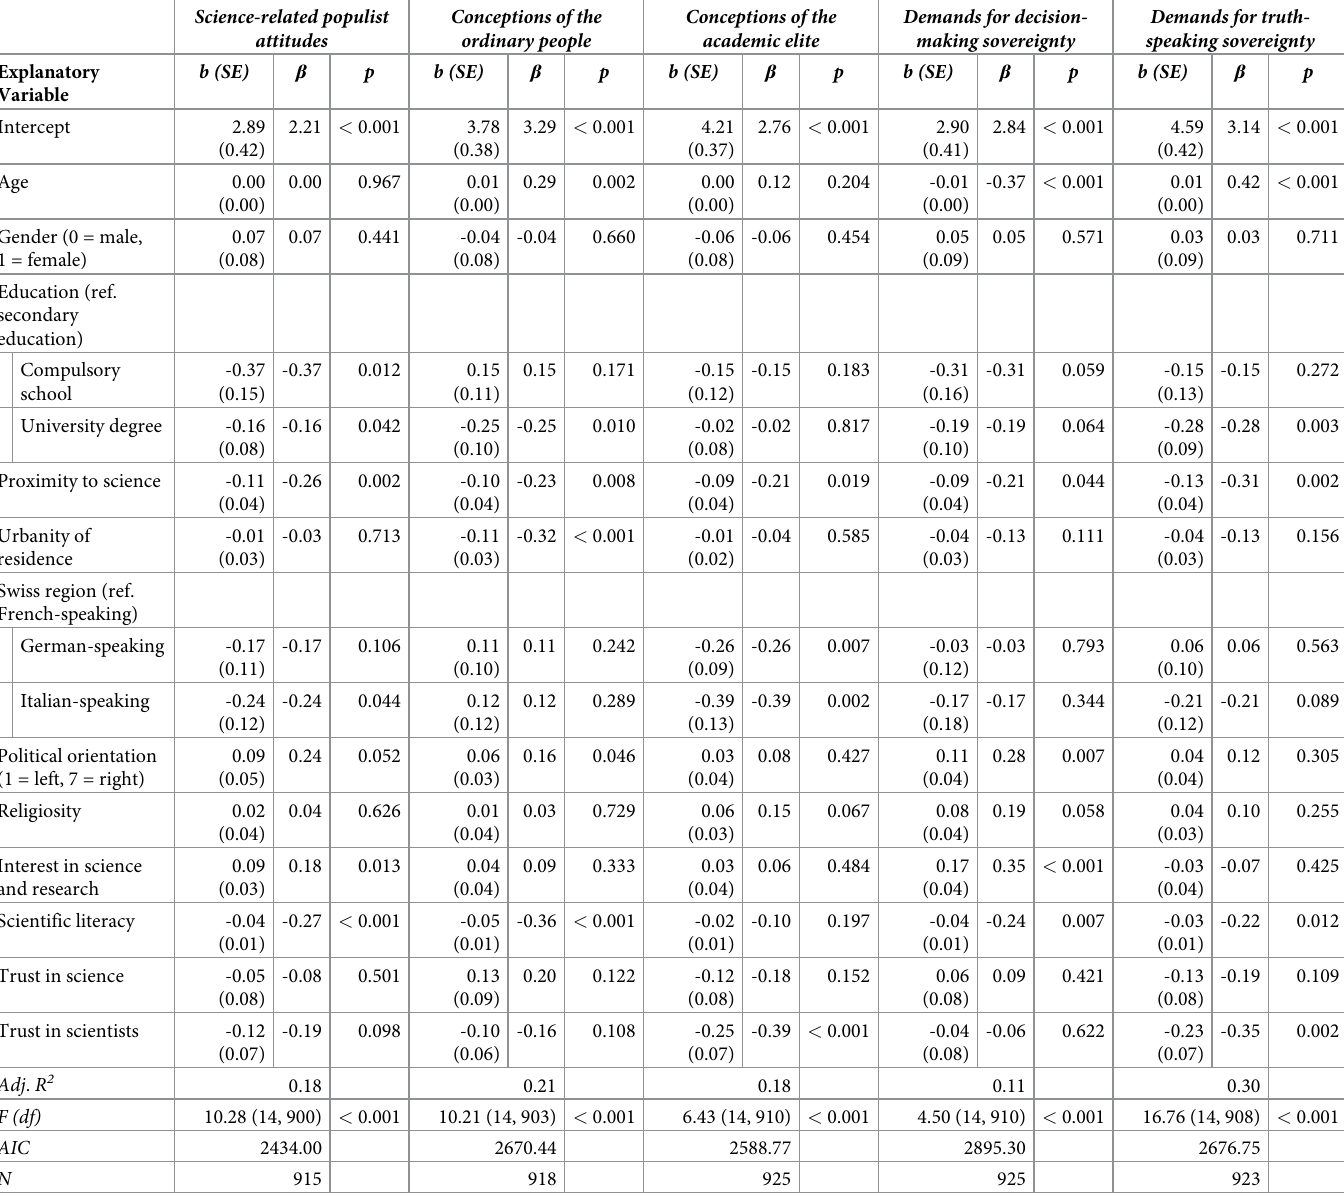
Table 2. Multiple linear regressions explaining science-related populist attitudes and its